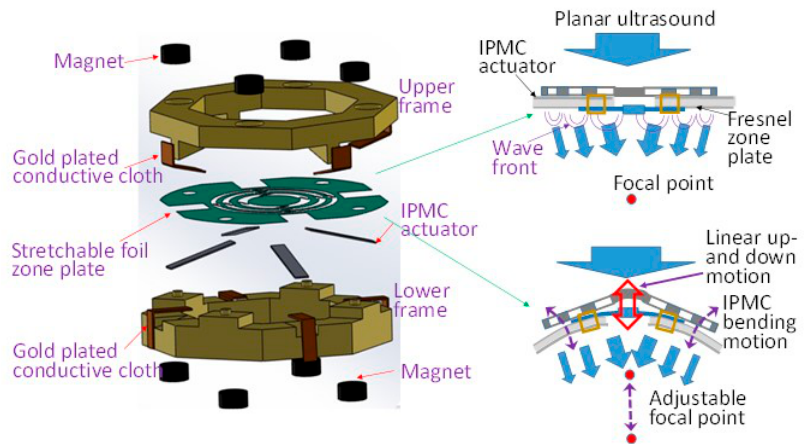
Figure 1. Concept of ionic polymer–metal composite (IPMC)-based soft engine manipulating stretchable zone plate for adjusting the focus of ultrasonic beam.